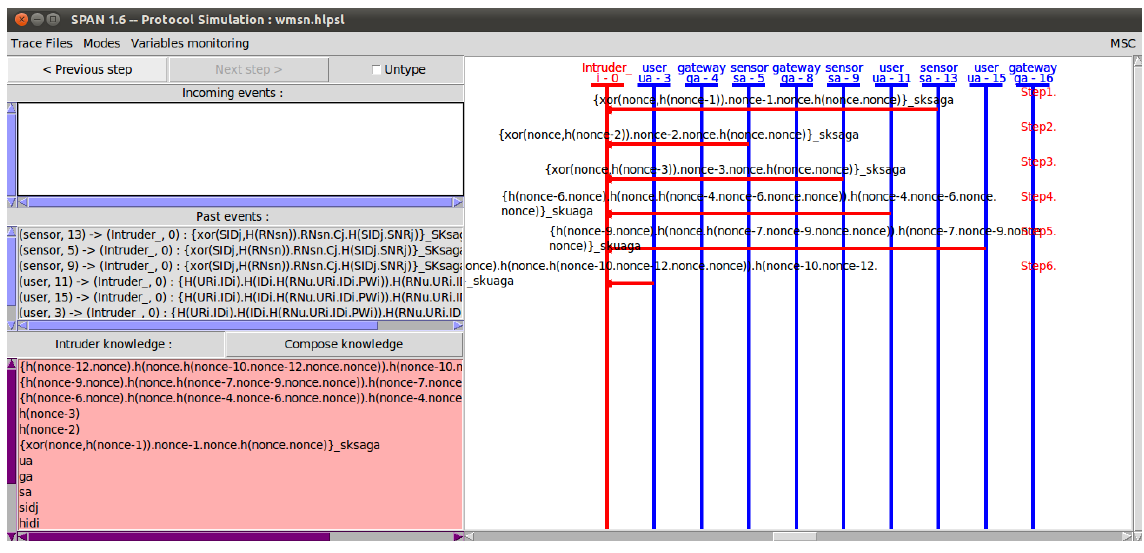
Figure 6. AVISPA implementation